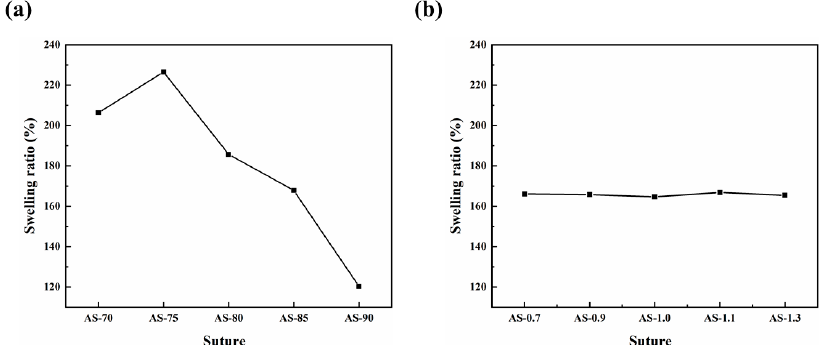
Figure 3. Effects of chitosan’s DD ( a ) and Mv ( b ) on swelling ratio of their monofilaments.